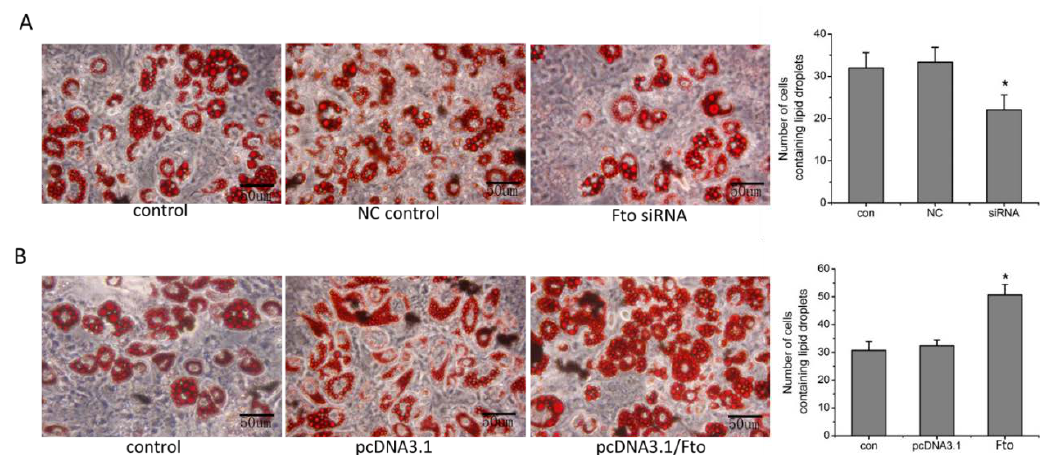
Figure 4. Effects of Fto on 3T3-L1 cells differentiation: ( A ) The NC control and Fto siRNA transfected 3T3-L1 cells, together with parental pre-adipocytes were treated with differentiation media at 24 h after transfection, and were subsequently incubated for 10 to 14 days. Cells were fixed and stained with Oil Red O. Then the cells were photographed under a phase contrast microscope, and five randomly selected microscopic fields for each group were then counted; scale bar, 50 µ m. * p < 0.05 versus NC group. ( B ) The differentiation of Fto overexpressed 3T3-L1 cells were assayed as described above. * p < 0.05 versus empty pcDNA3.1 vector group.